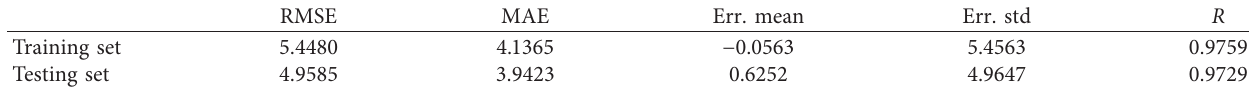
Table 3: Summary of different quality assessment criteria for the best RF predictor. RMSE MAE Err. mean Err.